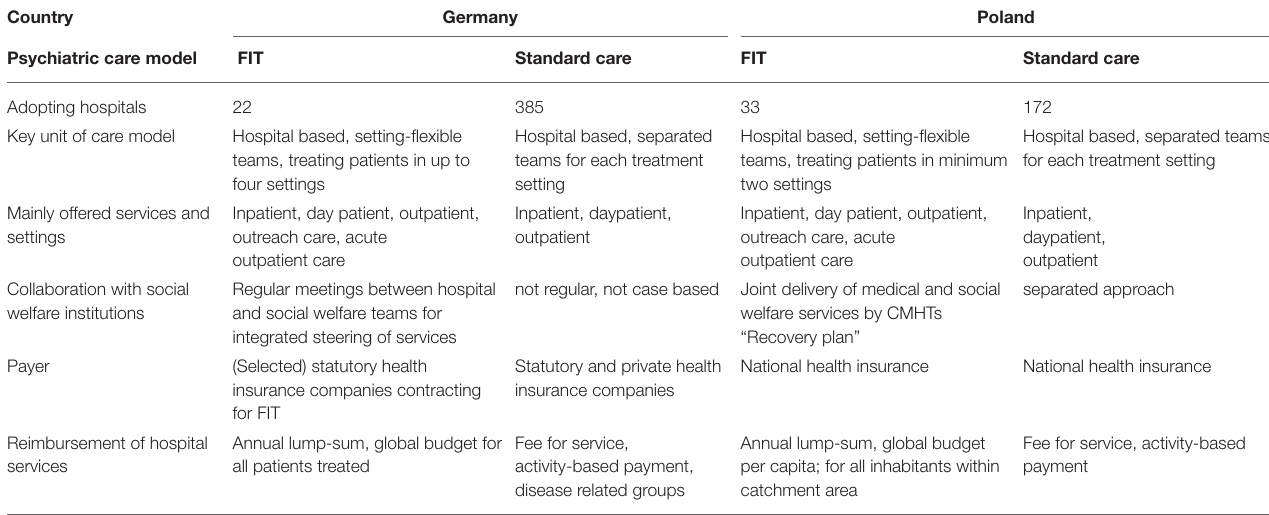
TABLE 1 | Basic differences between standard psychiatric hospital care and flexible and integrative treatment (FIT) models in Germany and Poland.